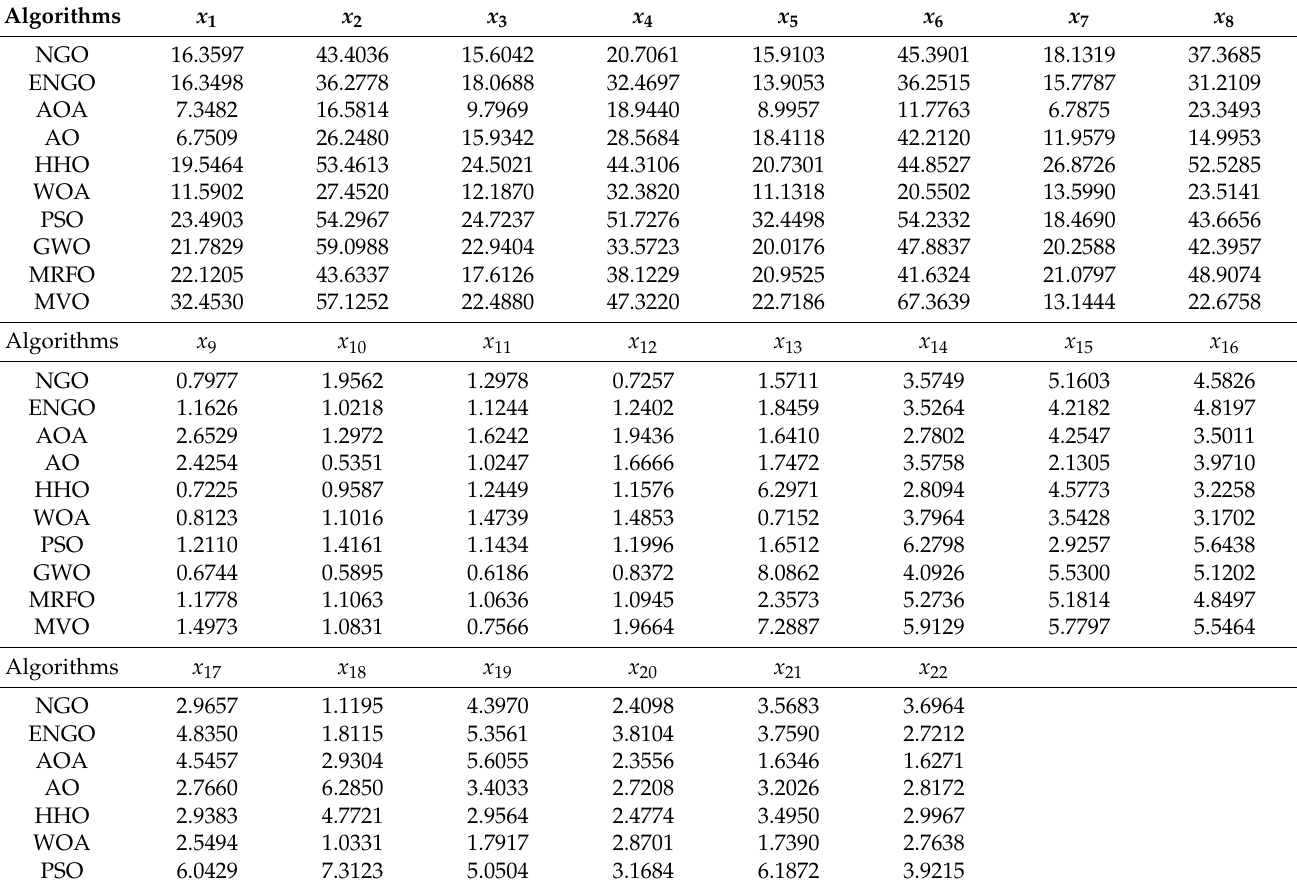
Table 9. The best solution of the four stage gearbox design problem obtained by the different